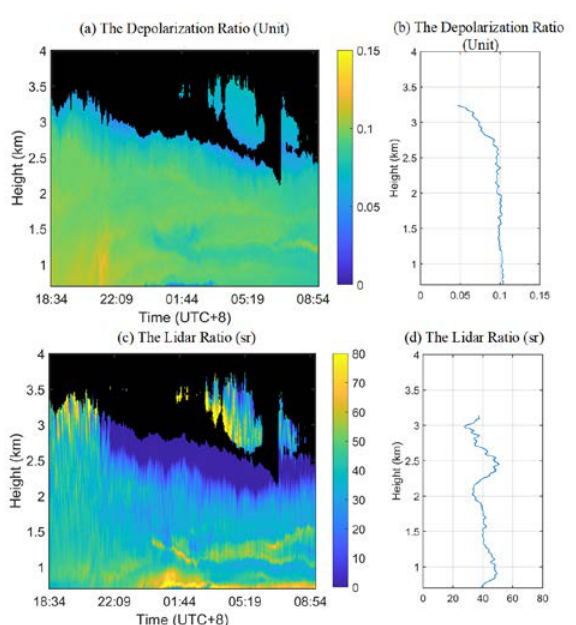
Fig.2. Measured aerosol’s depolarization ratio (a & b) and lidar ratio (c & d) in Hangzhou from 18:34 pm (UTC + 8), 12 March 2019 to 8:54 am (UTC + 8), 13 March 2019.